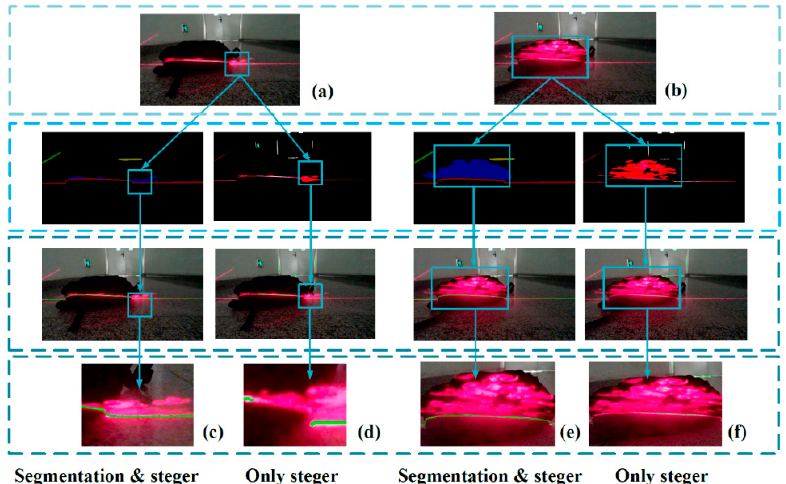
Figure 6. Detection and extraction of laser stripe center. ( a , b ) Two different kind of noises. (c,e) The results of our method(the enlarged region of the center extraction). (d,f) The results of traditional Steger method.